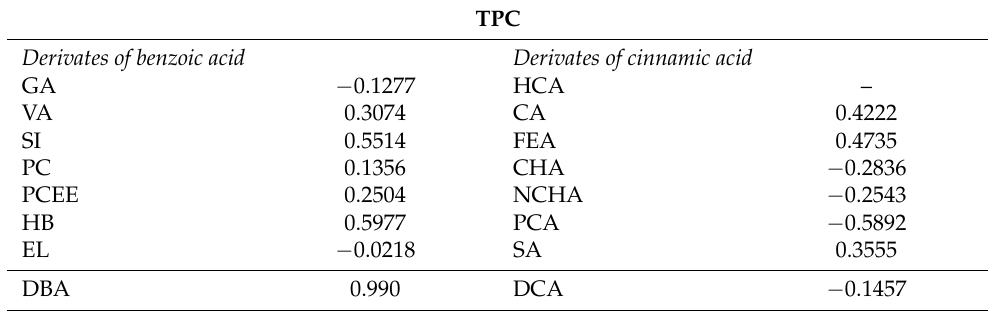
Table 7. Correlation coefficients (R) between total phenolic content (TPC) and individual phenolic acids (GA, VA, SI, PCA, PCEE, HB, EL, HCA, CA, FEA, CHA, NCHA, PKA and SI), total derivatives of benzoic acid (DBA) and total derivatives of cinnamic acid (DCA) in the selected Sorbus